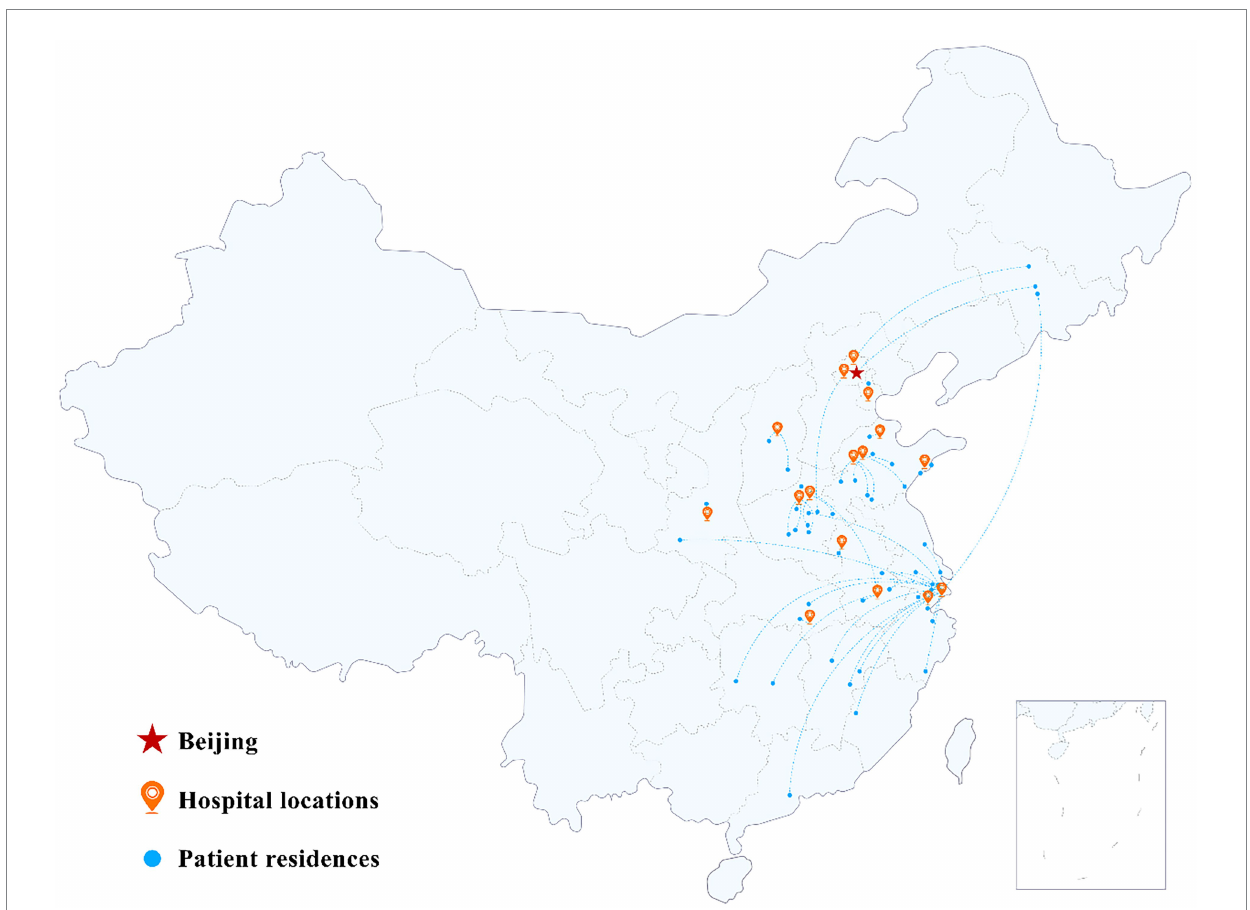
FIGURE 2 Map of the patient residences and hospital locations. The red star, orange location symbols, and blue dots represent Beijing, hospital locations, and patient residences,